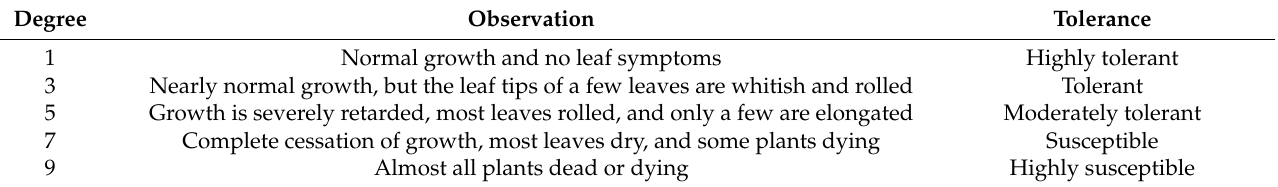
Figure 2. Frequency distribution for the degree of salt tolerance at the seedling stage in the japonica - MAGIC population. Table 1. Evaluation criteria for salt tolerance at the seedling stage in this study.